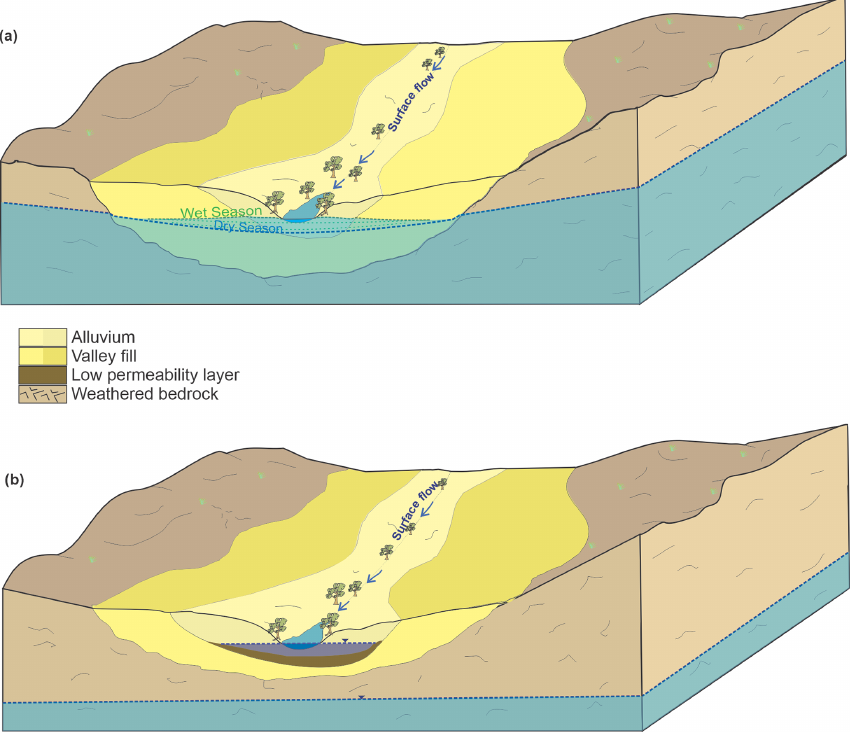
Figure 2. Schematic illustration of pools that are maintained by throughflow from the adjacent alluvial sediments. The water in these alluvial sediments can be either (a) connected to the unconfined aquifer, or (b) form a perched aquifer if the water is stored over a low permeability